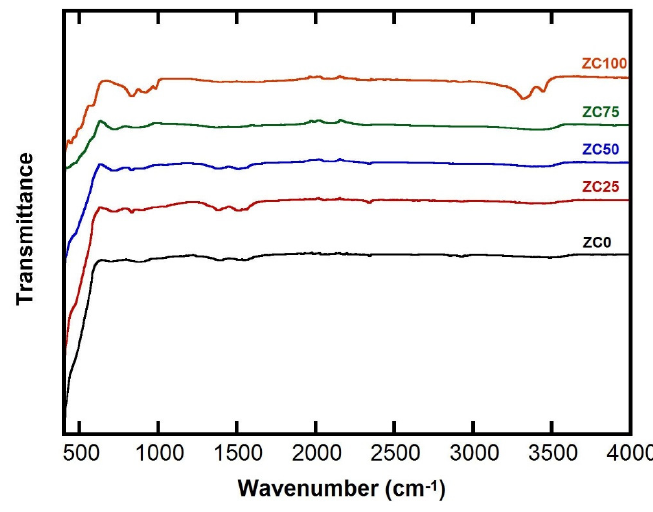
Figure 1. FTIR spectra of the ZC0, ZC25, ZC50, ZC75, and ZC100 samples. Figure 2a represents the FTIR of Acacia nilotica pods’ extract, sample ZC50 (b) after precipitation, (c) after hydrothermal treatment and drying and (d) after calcination. The FTIR of Acacia nilotica pods’ extract shows a very broad band between 2800–3600 cm − 1 which may correspond to the stretching vibration of aromatic and aliphatic OH groups (3200–3500 cm − 1 ) or stretching of aromatic and aliphatic C-H (3000–3100 cm − 1 ). A sharp finger-like peak around 1500–1700 cm − 1 stands for carbonyl groups or bending of aromatic